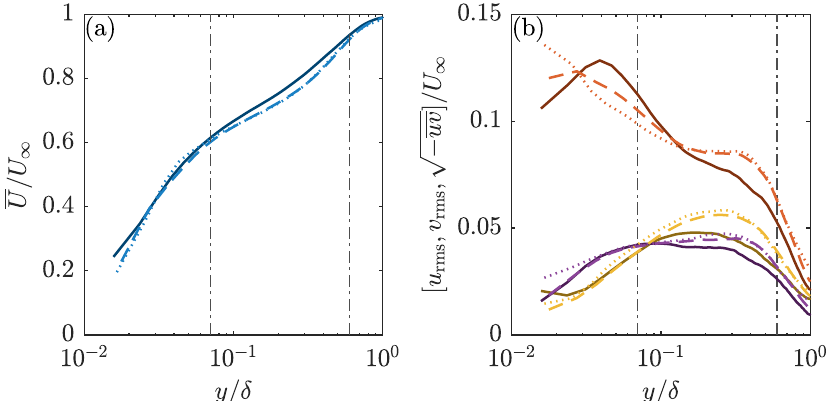
Figure 3. Comparison of the RW-DRF, CW-DRF (both from actuation condition iii), and canonical mean flow statistics ( x / δ = 4.7): ( a ) mean streamwise velocity (blue), ( b ) streamwise (red) and wall-normal (yellow) turbulence intensities, and Reynolds shear stress (purple). Line styles are as follows: (solid) canonical, (dashed) RW-DRF, (dotted) CW-DRF. The vertical dash-dotted lines indicate 0.07 < y / δ < 0.6.